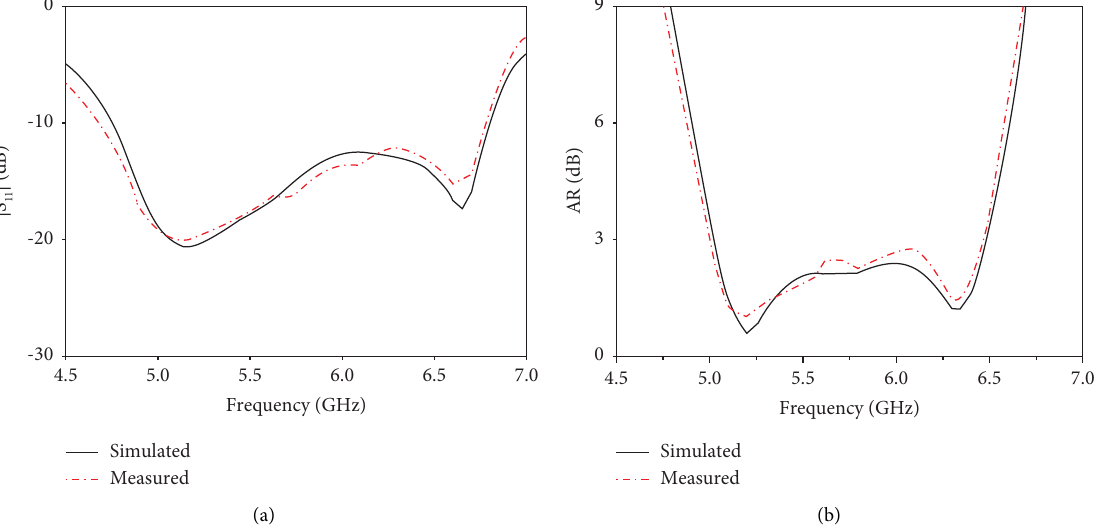
11 | values and (b) AR curves.